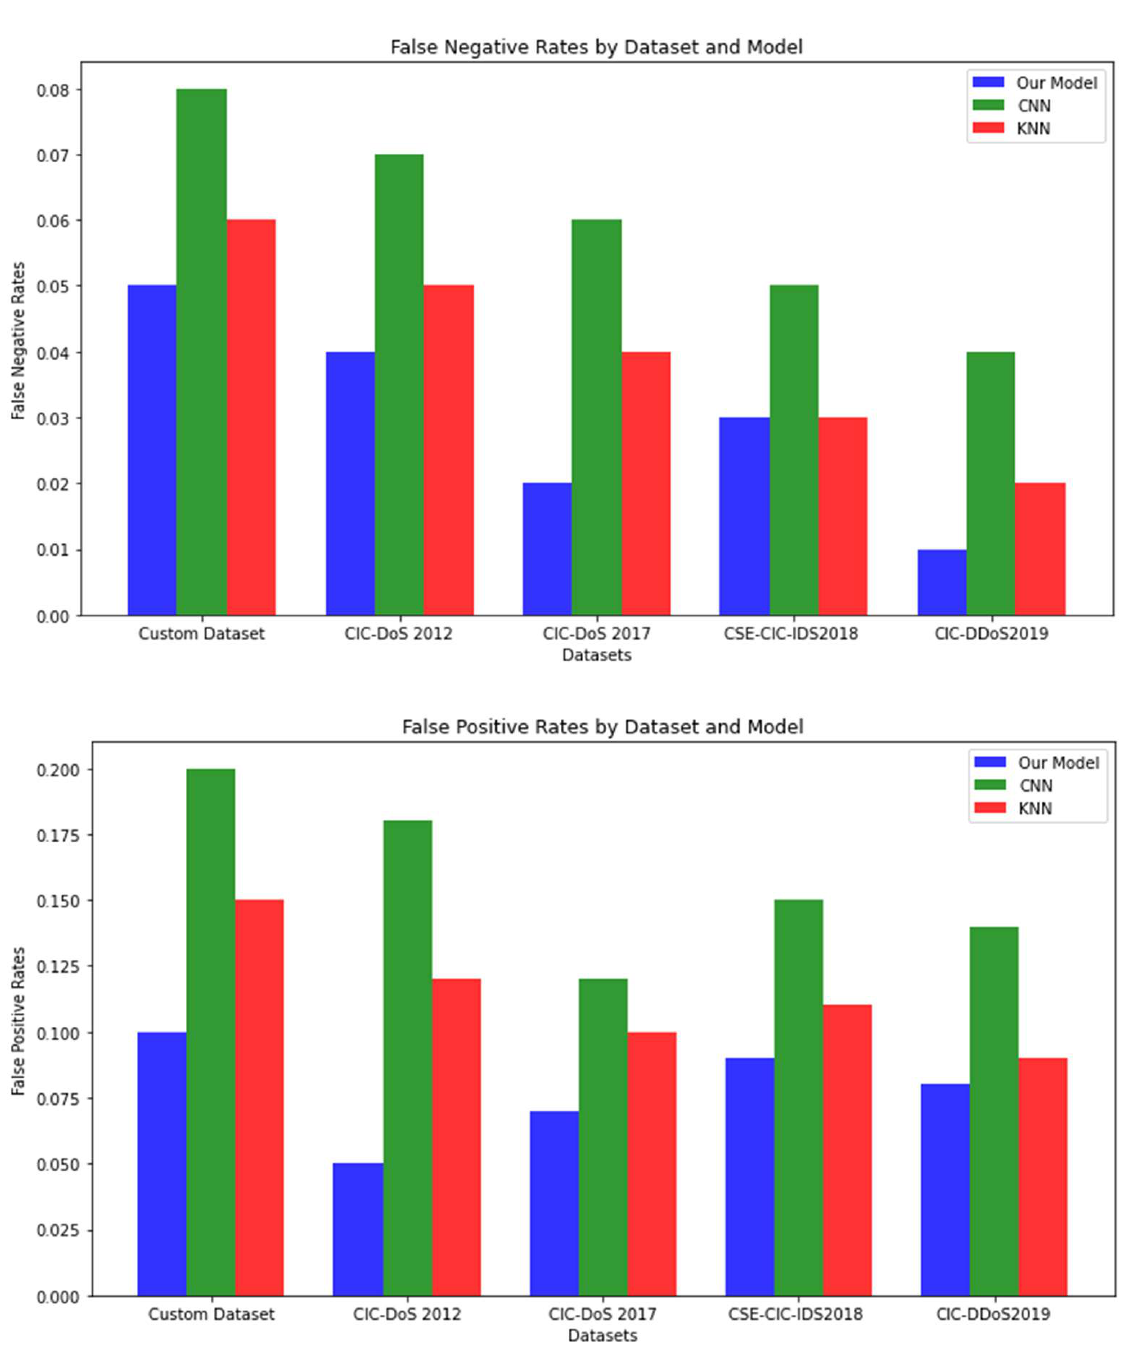
Figure 8. False positive and false negative.